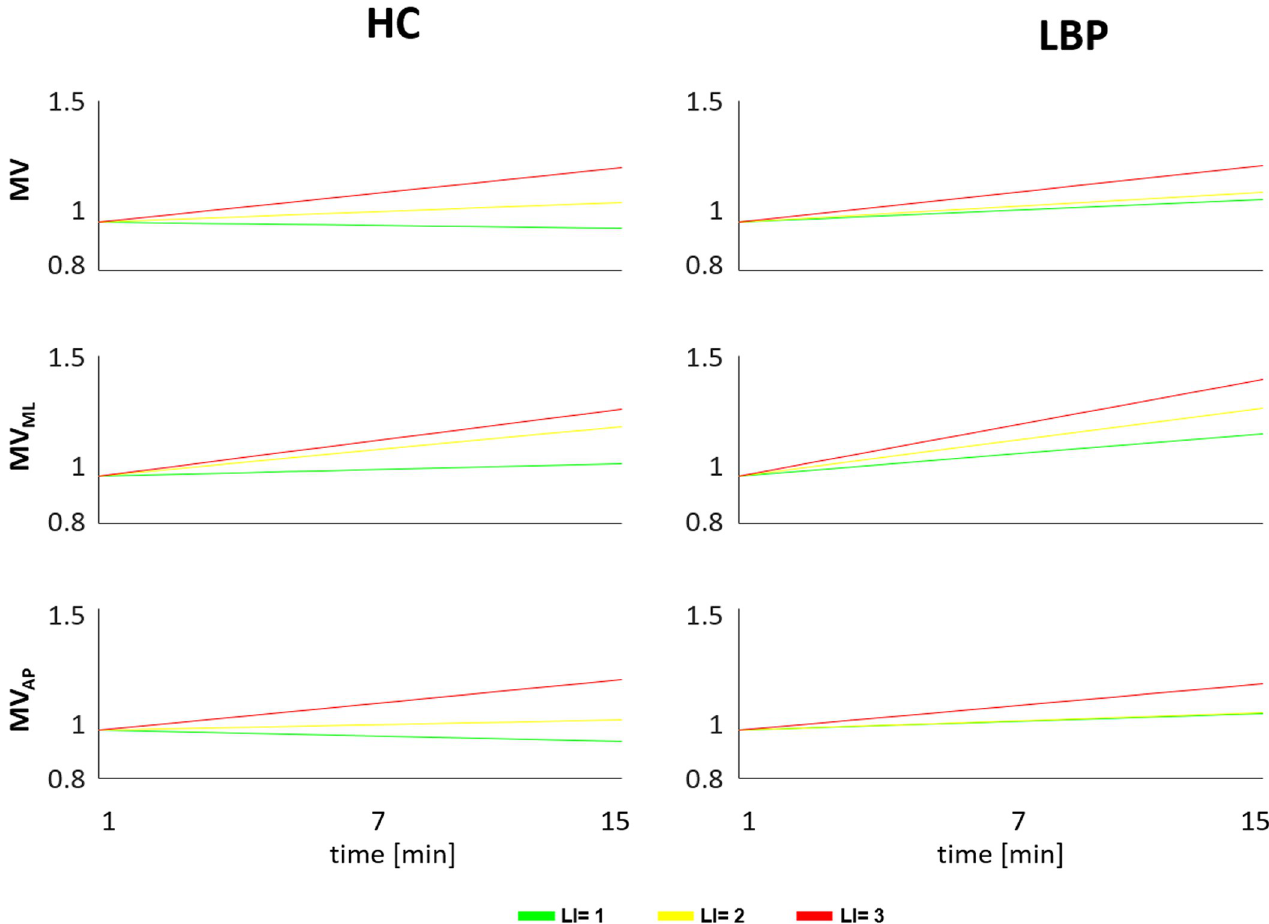
Fig 5. Regression line of the centre of pressure parameters. The regression line for each risk level in both groups (Healthy Control—HC left column and people with Low Back Pain–LBP right column) for mean velocity in the average of the CoP (MV) and in medio-lateral (MV ML ) and antero-posterior (MV AP ) directions considering the mean of all repetitions within each minute of entire trail of lifting cycles. LI: Lifting index. � Statistical significance (p < 0.05).